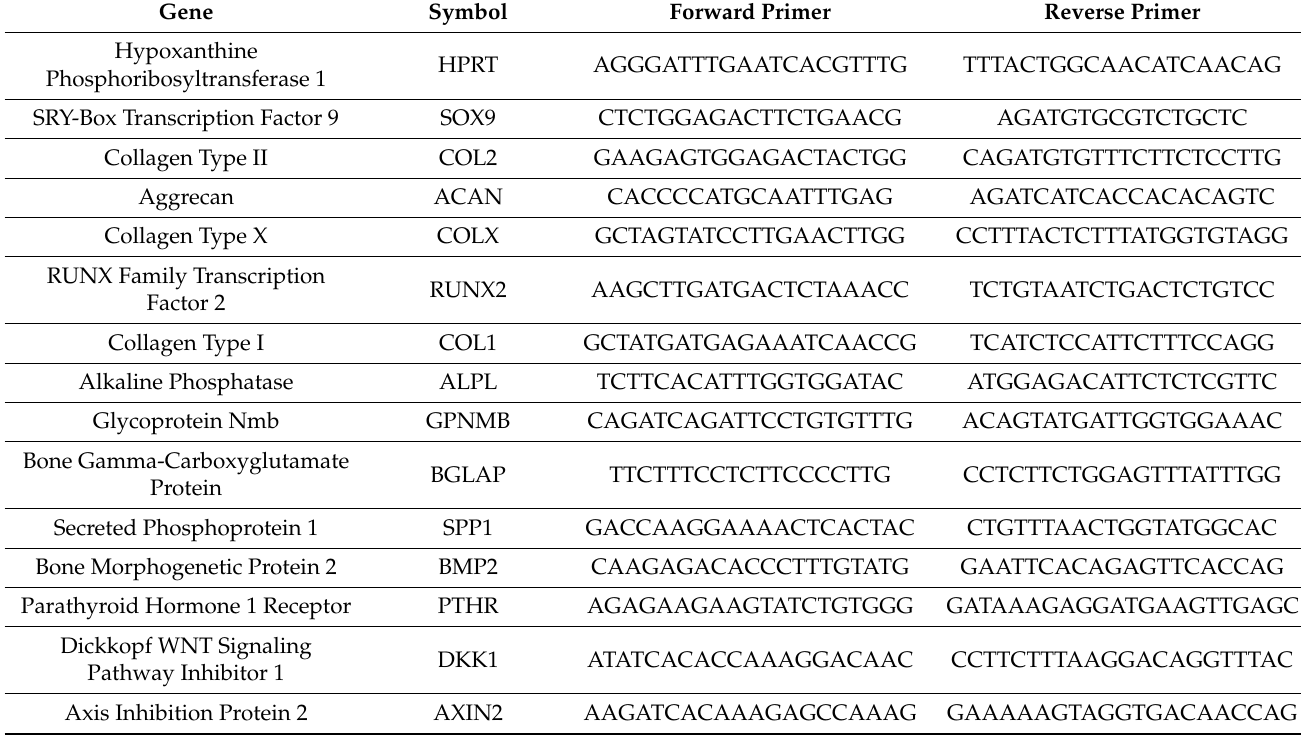
Table 1. Primers employed for real-time PCR